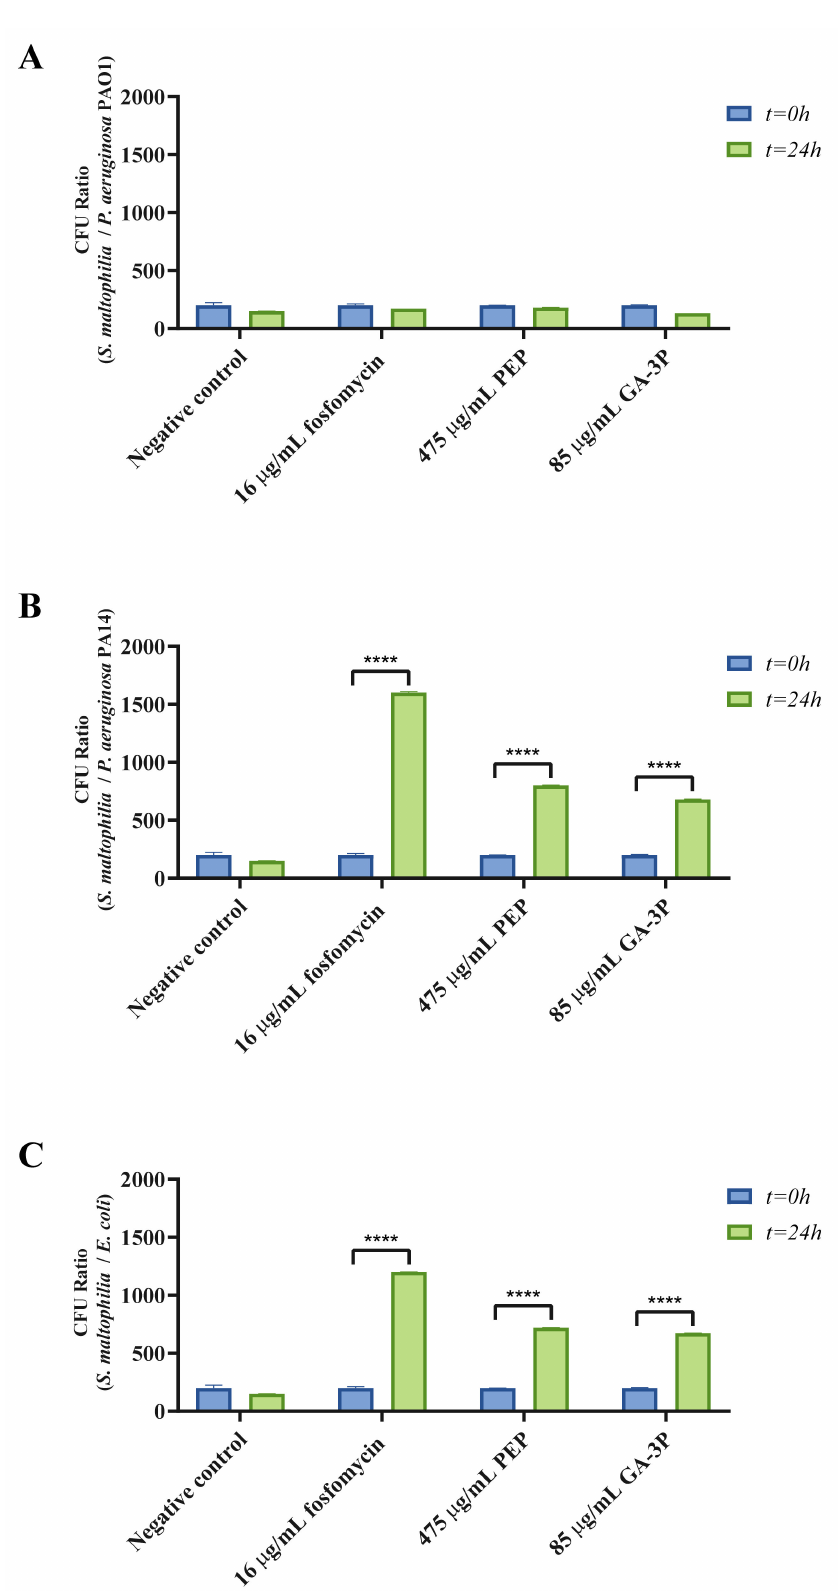
Figure 5. Survival of S. maltophilia D457 when co-cultured with heterologous bacteria after fosfomycin, PEP, or GA-3P pretreatments. Results are presented as the ratios of S. maltophilia CFUs to the CFUs of other species at t = 0 and t = 24 h. On the one hand, tested compounds were not able to